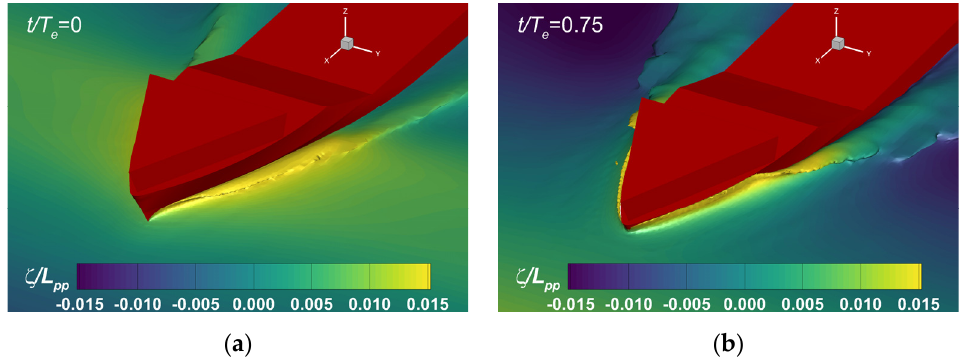
Figure 27. Bow wave profiles computed in the head sea case at: ( a ) 𝑡 𝑇 (cid:3032) ⁄ = 0 ; ( b ) 𝑡 𝑇 (cid:3032) ⁄ = 0.75 .